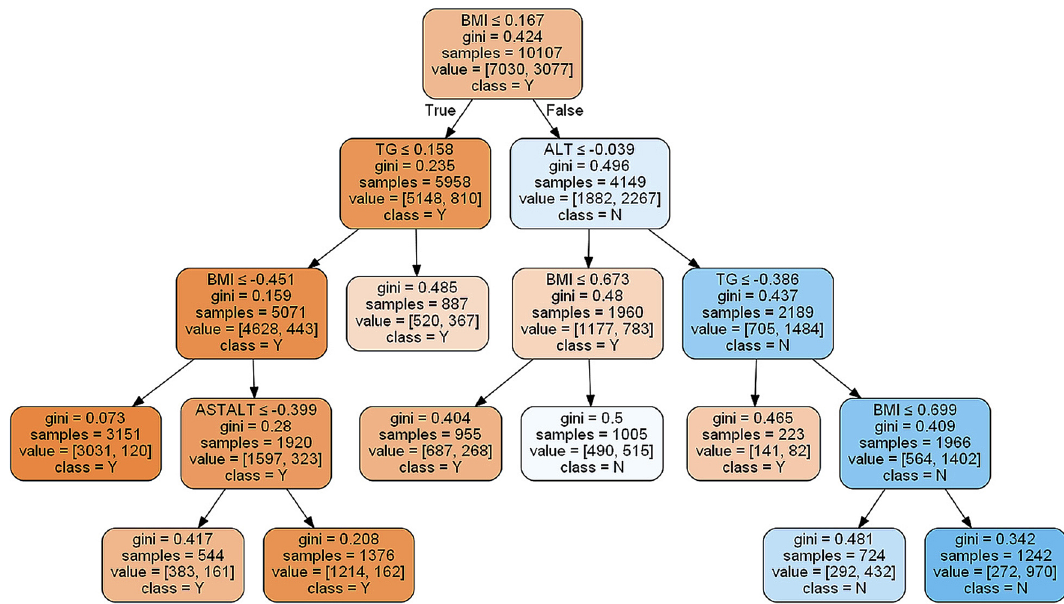
Figure 2. Classifier based on Decision tree. BMI body mass index; TG triglyceride; ALT alanine aminotransferase; AST aspartate aminotransferase; ASTALT the ratio of